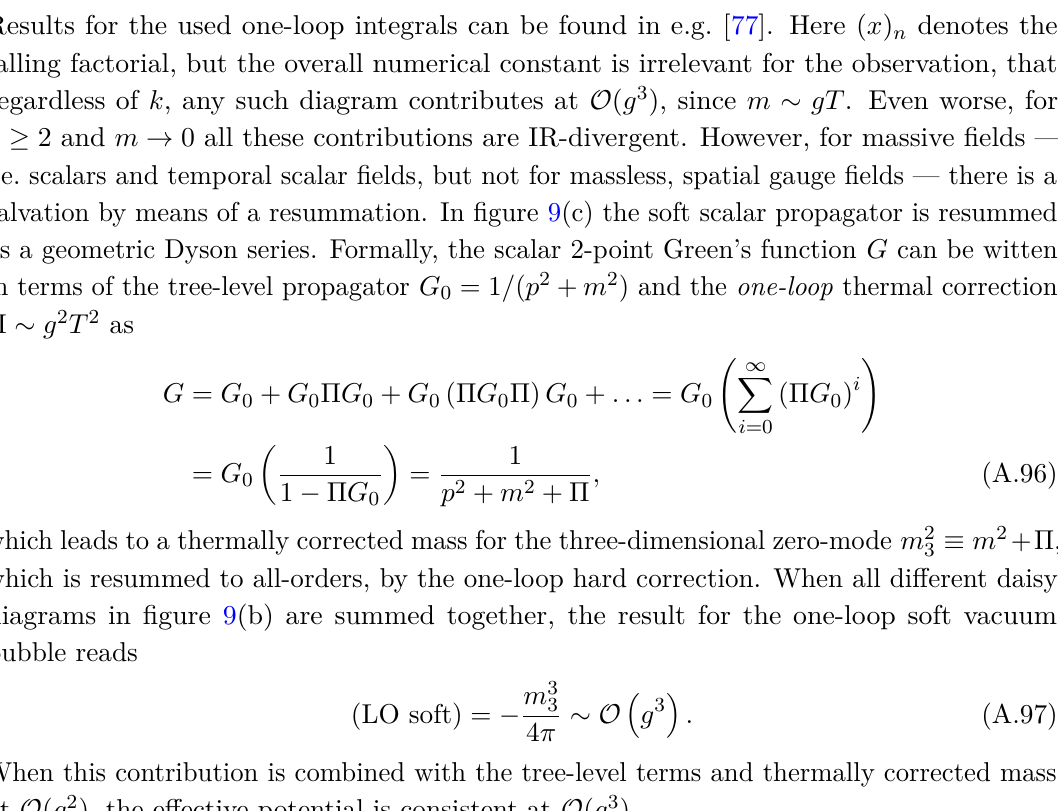
Figure 10 . Illustration of higher order resummations in NLO dimensional reduction, going beyond leading one-loop daisy resummation of the mass. (a): two-loop resummation of the mass parameter. (b): one-loop resummation of the couplings. (c): one-loop resummation of the fields, from the part dependent on the external momentum. Here a dashed line represents a soft field, and a double line and wiggly line hard scalar and gauge field modes, respectively. All NLO effects in dimensional reduction contibute at O ( g 4 )